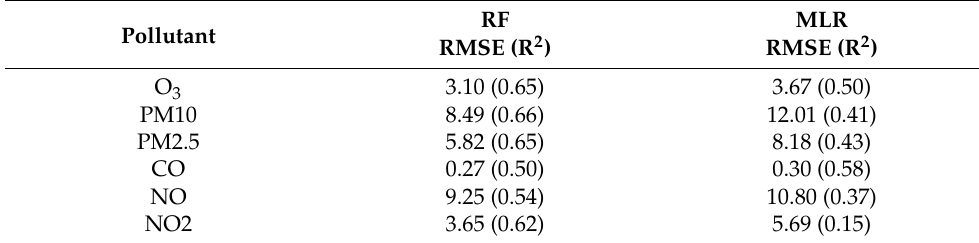
Table 1. RF and MLR models’ performance calculated for the validation set. Values are averaged for all available